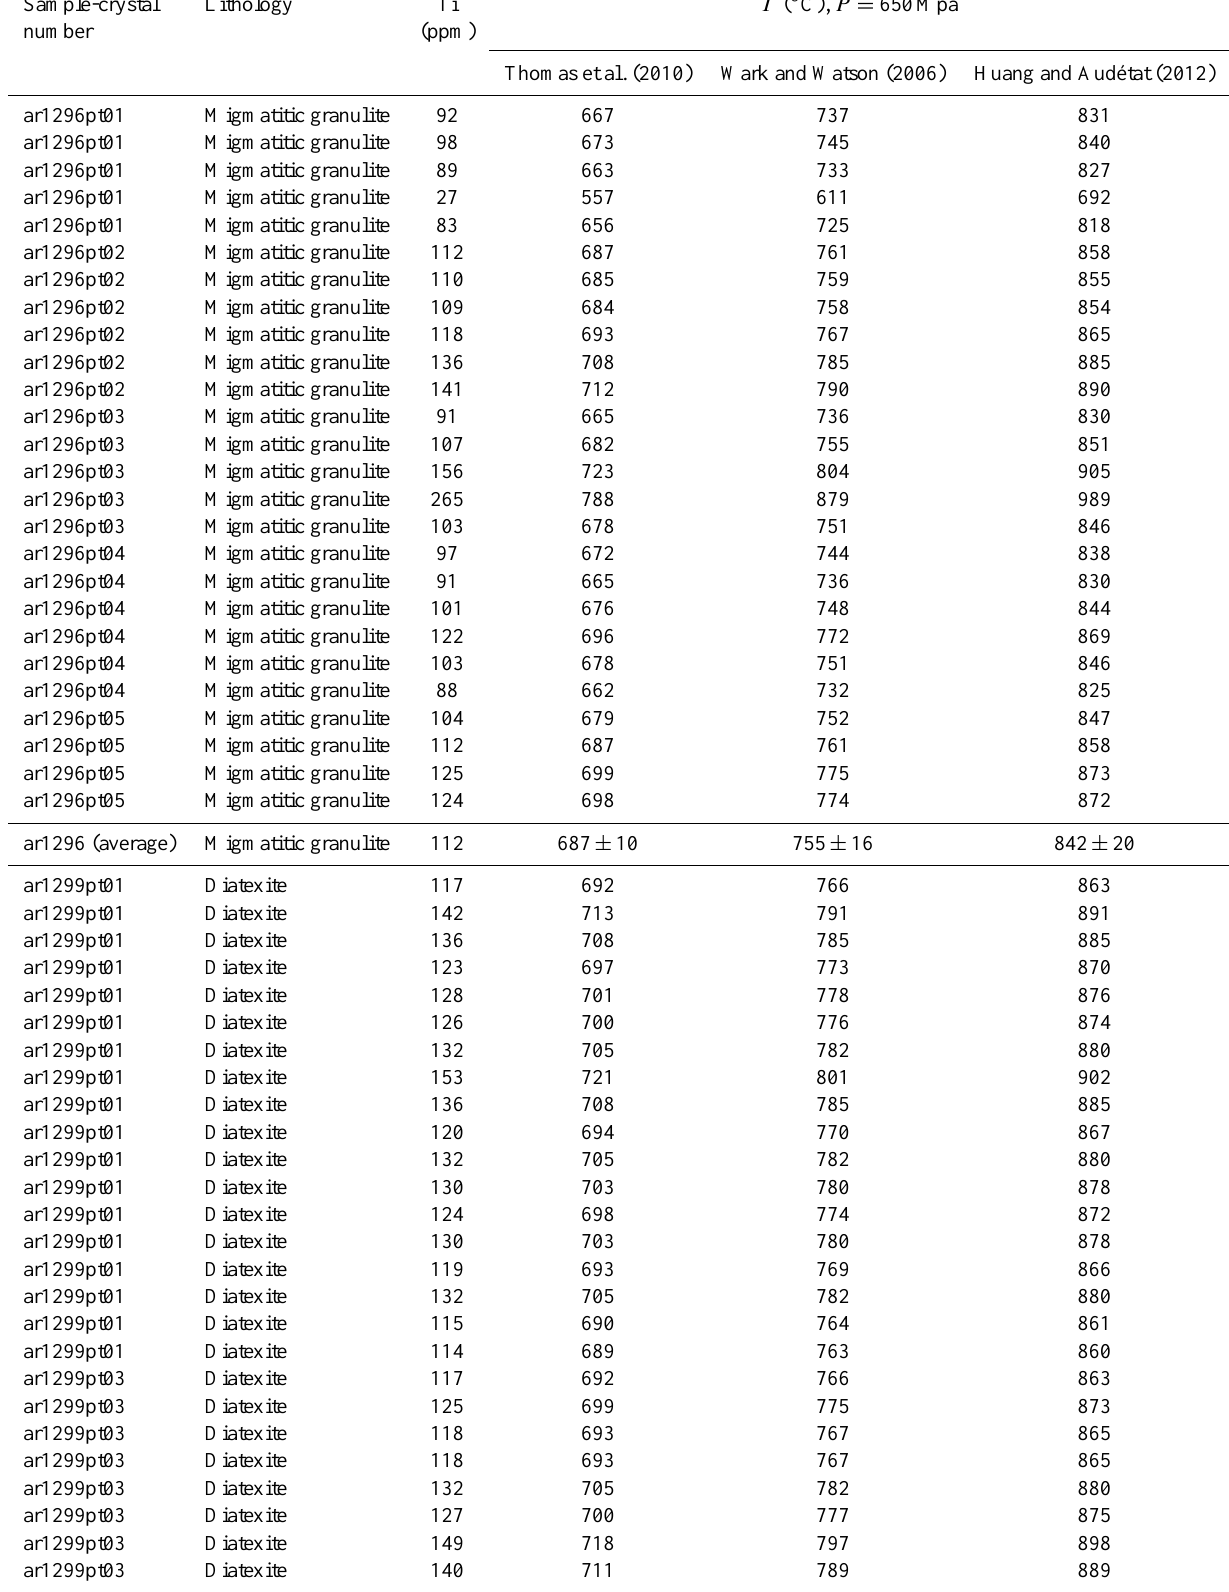
Table 1. Titanium content and calculated TitaniQ temperatures for each analytical spot, with the average values shown for each sample.